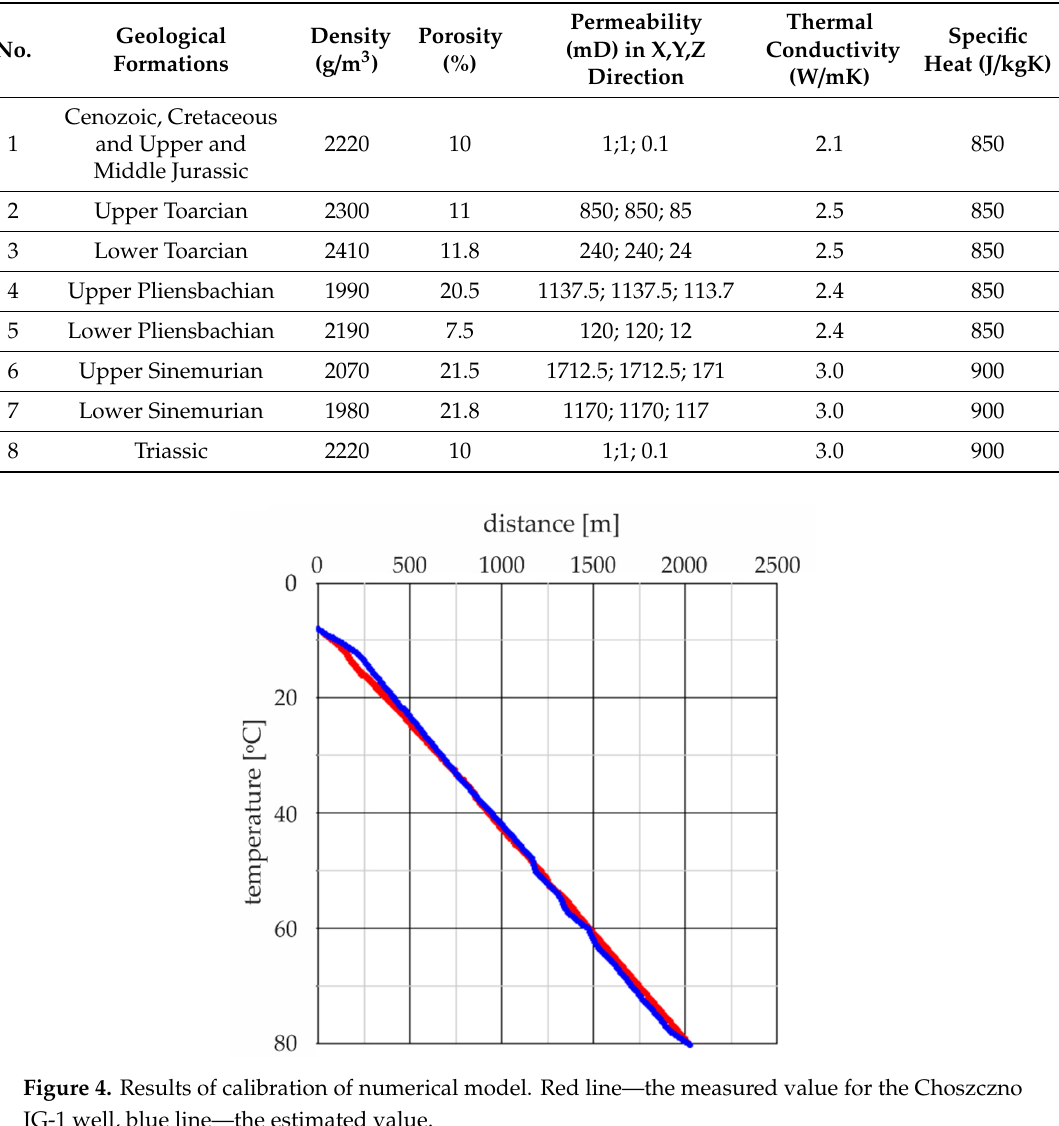
Table 1. Parameters defined for the model of Choszczno region [55].